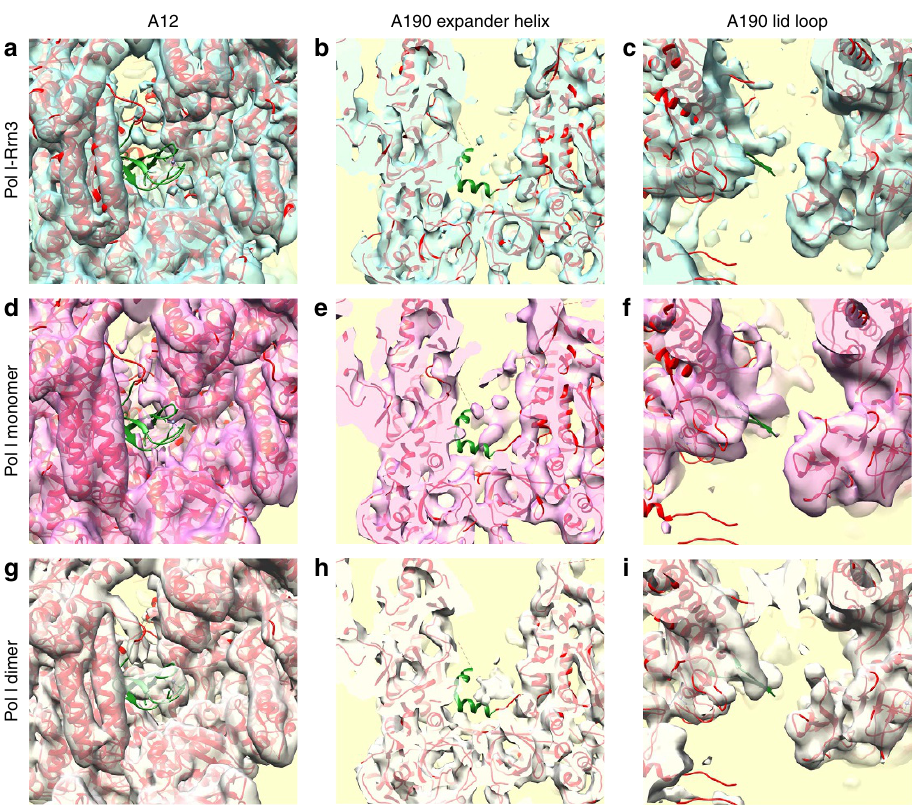
Figure 4 | Comparison of key structural features in different Pol I conformational states. The position of the A12.2 C-terminus ( a , d , g ) the A190 expander helix ( b , e , h ) and the A190 lid loop ( c , f , i ) are shown in the cryo-EM maps of the Pol I- Rrn3 complex ( a – c ) the Pol I monomer ( d – f ) and the Pol I dimer ( g – i